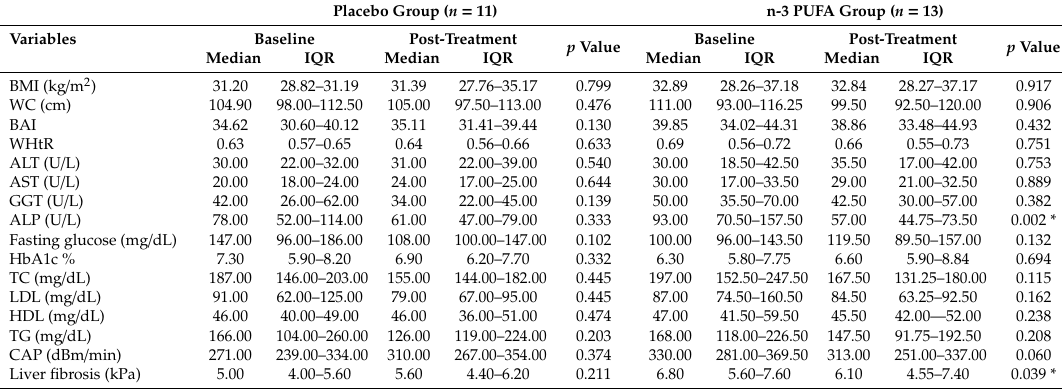
Table 2. Changes in anthropometric, biochemical, and clinical outcomes of non-alcoholic fatty liver disease patients after the intake of n-3 PUFA or placebo for six months.